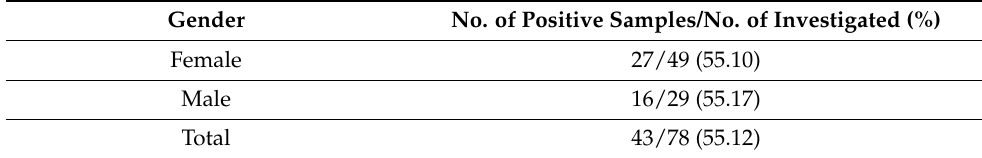
Table 1. Distribution of positive skin samples for Staphylococcus spp., according to gender. Gender No. of Positive Samples/No. of Investigated (%) Female 27/49 (55.10) Male 16/29 (55.17) Total 43/78